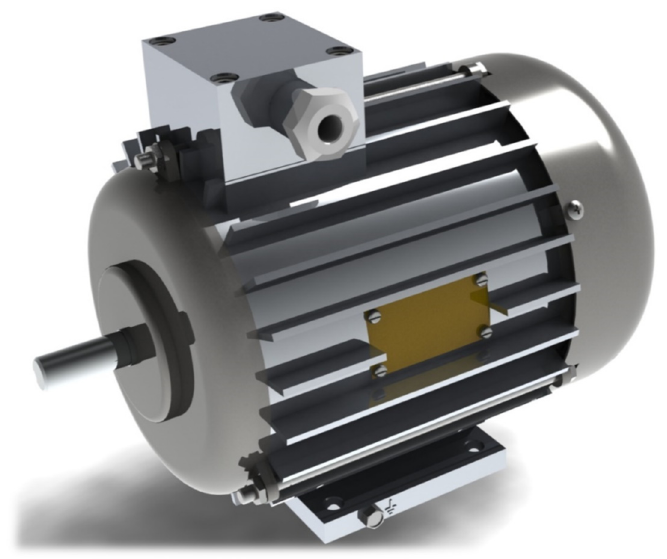
Figure 6. SolidWorks. 3D model of an induction motor AIR 63V2.